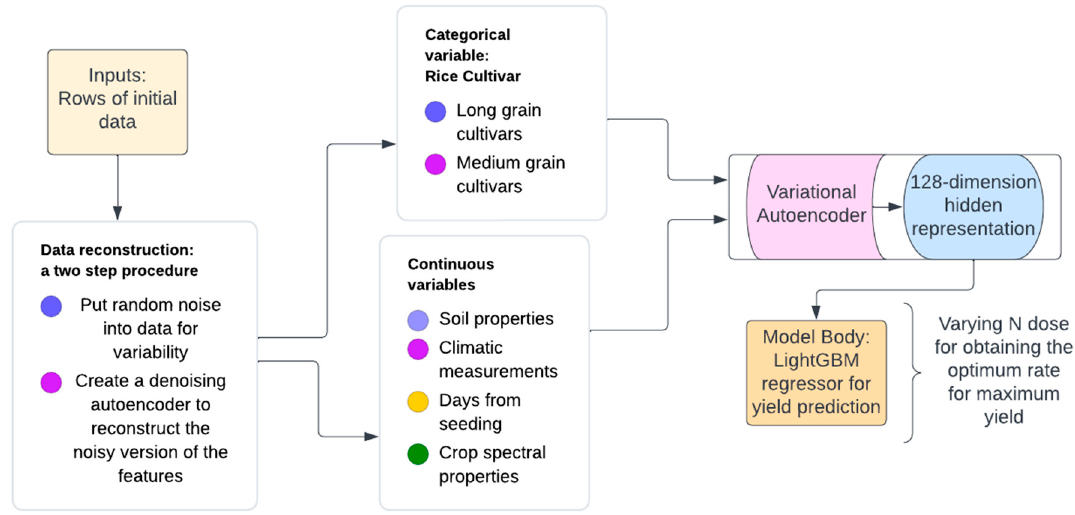
Figure 8. Pipeline of the variational autoencoder and the final model for defining the optimum N